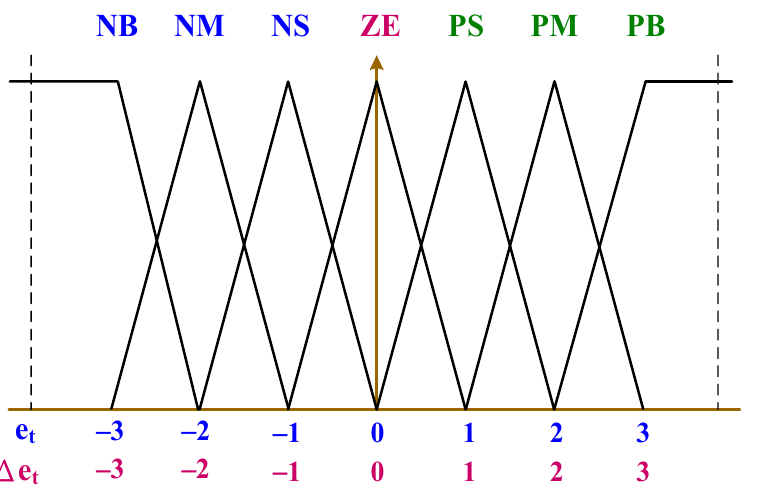
Figure 6. Seven–stage fuzzy membership function.